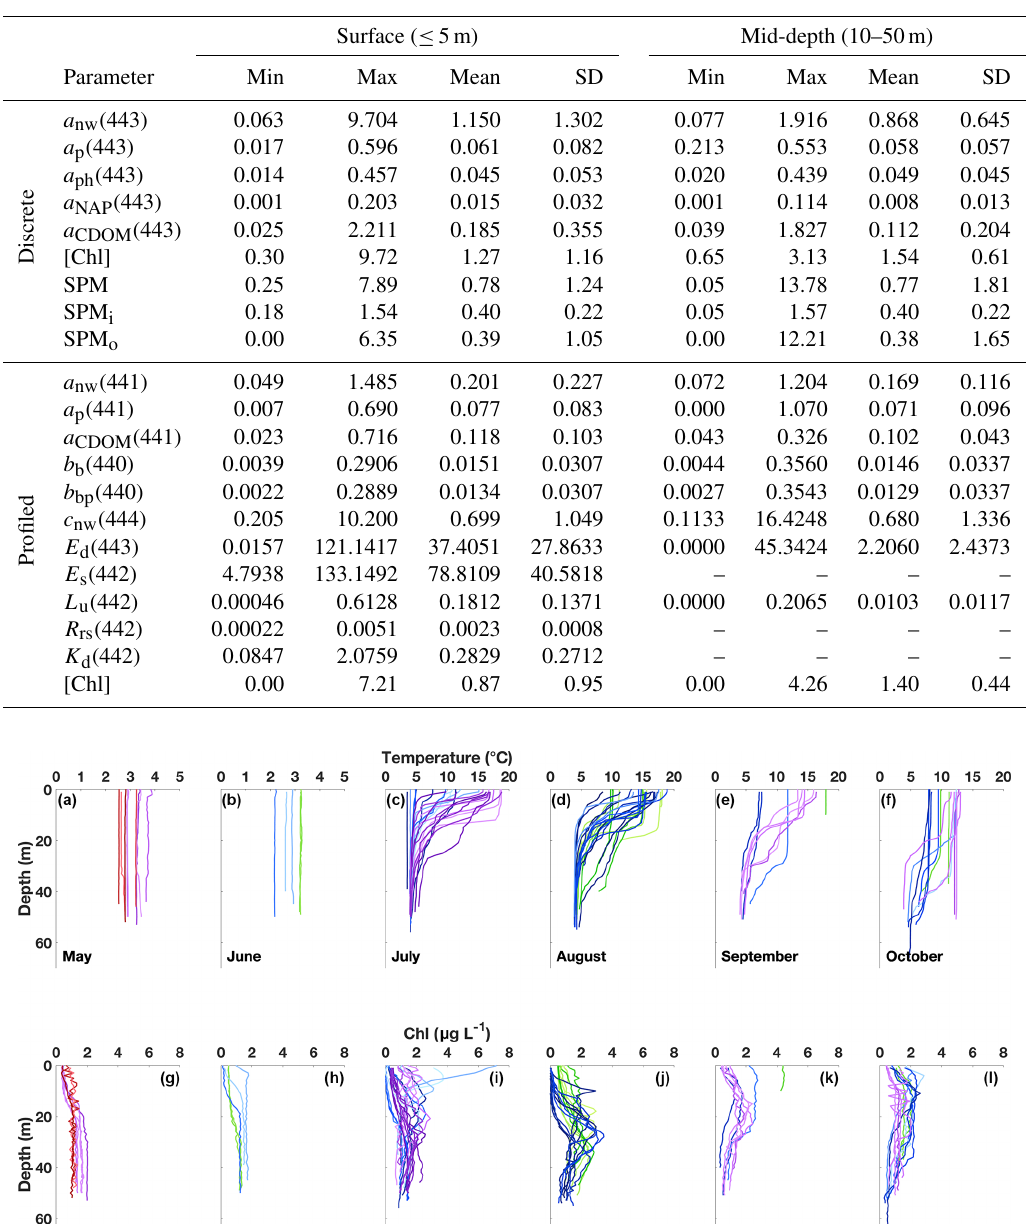
Table 2. Data product range, mean, and standard deviation for the entire dataset. Parameter definitions and units can be found in Table 1. Spectral data products are presented for the closest measurement to 443nm.